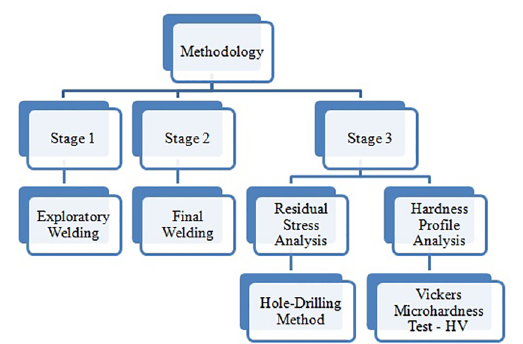
Figure 1. Flowchart of the stages performed in this work.